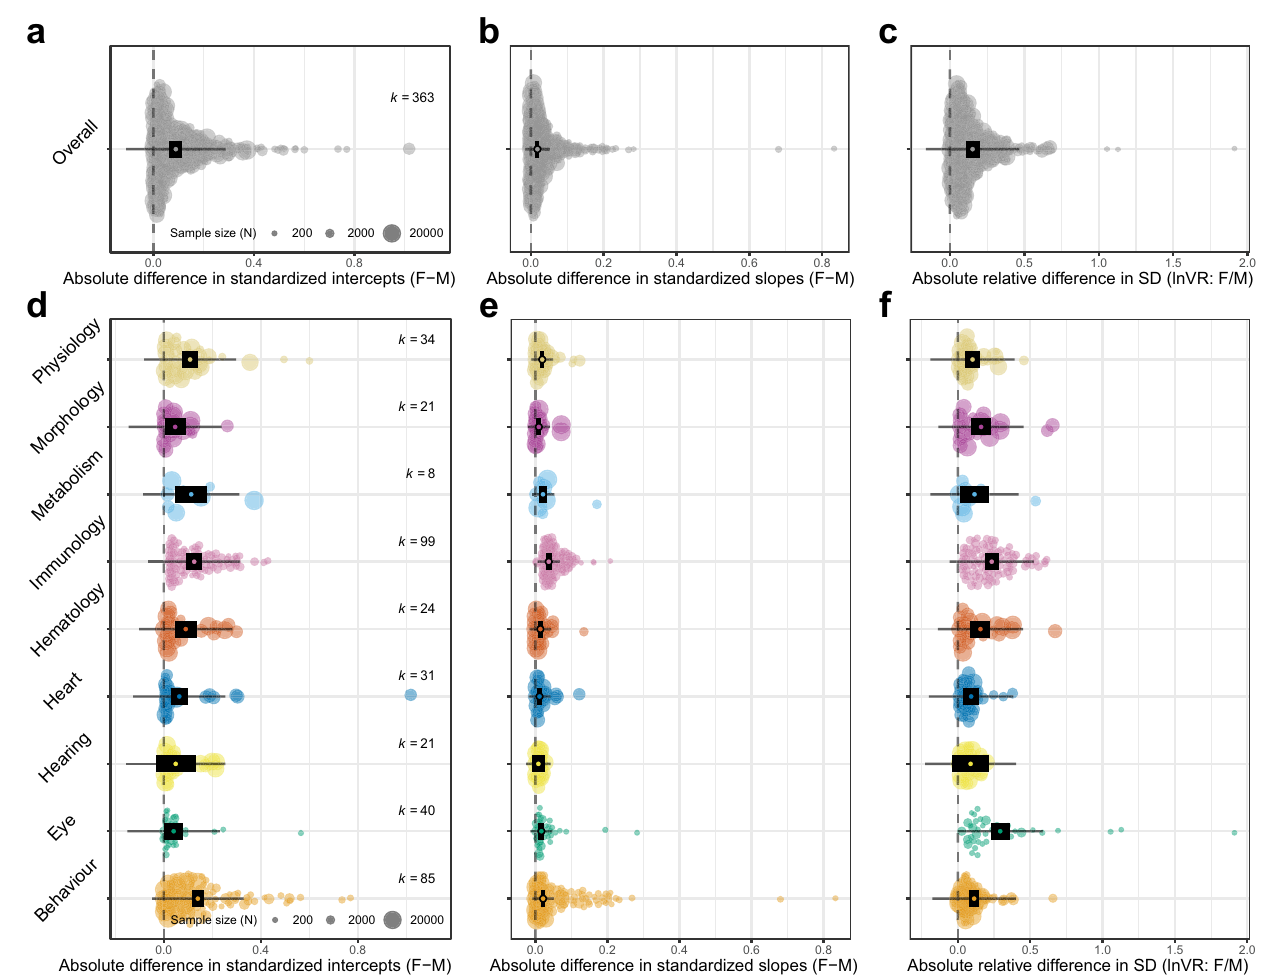
Fig.3|Orchardplotsillustratingresultsofmultivariatemeta-analysis. Orchard plots show model point estimate (black open ellipse) and associated con fi dence interval(CIs)(thickblackhorizontalline),95%predictionintervals (PIs)(thinblack horizontal line; PI represents heterogeneity), and individual effect sizes ( fi lled circle),which are scaledbytheirsample size(N),the number ofmice included per trait.Thenumberofeffectsizes(numberof phenotypictraits)isrepresented by k . a Overall difference between male and female absolute values for allometric